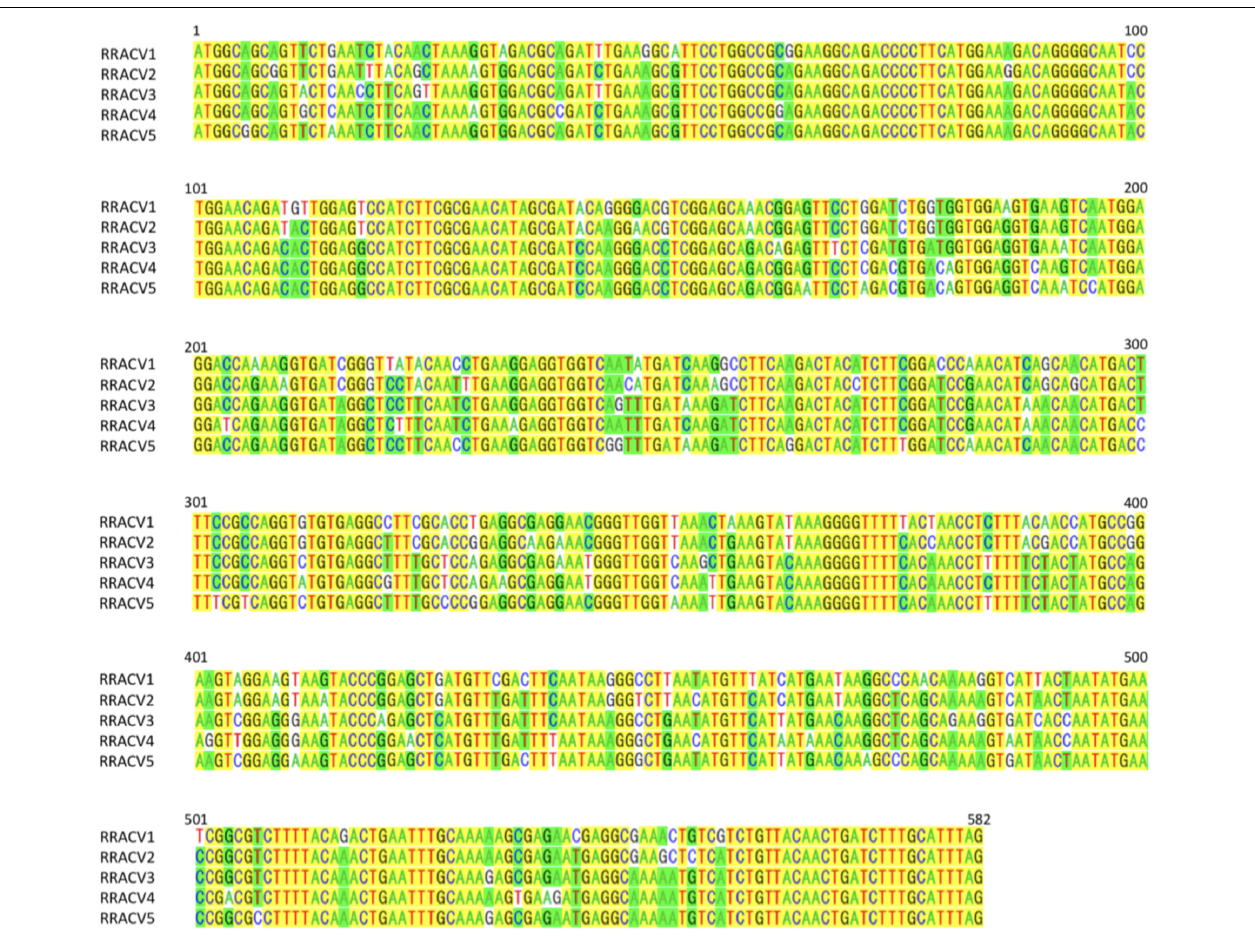
FIGURE 1 | Alignment of the nucleotide sequences of CP region of ACLSV-RRACVs detected in leaf samples of N. occidentalis plants inoculated with the RNA transcript of ACLSV from ARRD. Identical bases among the five SVs are filled in yellow, and if there are substitutions in the bases, they are filled in green (the number is dominant) or unfilled (the number is inferior).